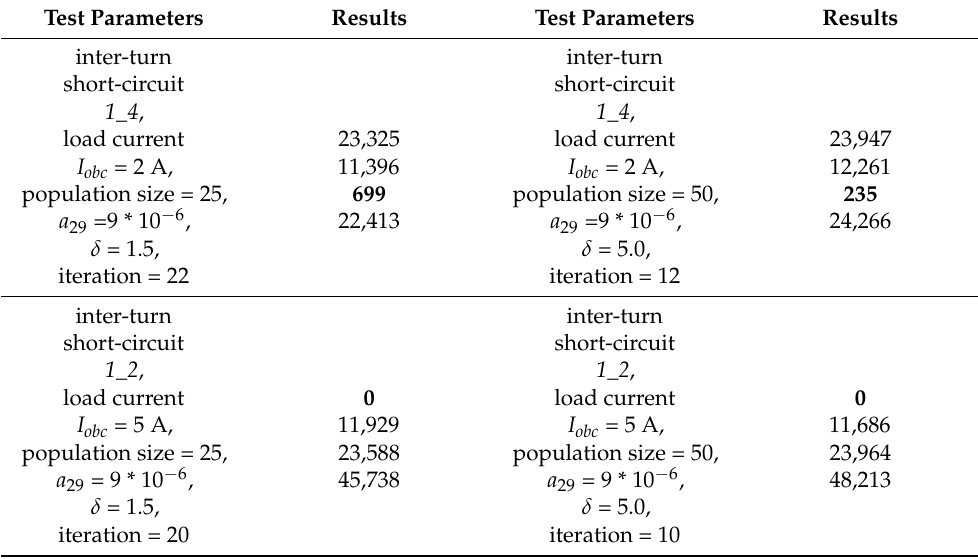
Table 4. Example results of H 2 tests for acceleration in d axis X— d x